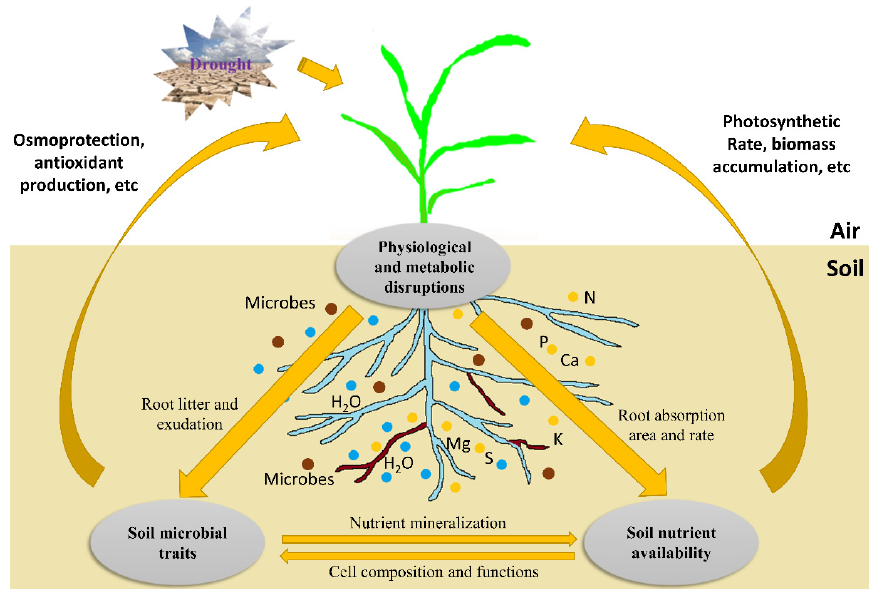
Figure 1. A framework showing drought effects on root physiological and metabolic processes and their interactions with nutrients and microbiomes in soil. Severe drought causes physiological and metabolic disruptions (see below for details). On the one hand, these disruptions influence nutrient uptake and metabolisms in plants, and vice versa. This feedback, in turn, affects biomass accumu- lation and grain yield. On the other hand, the inhibition of root litter and exudation production alters soil microbial traits (e.g., abundance, composition, and activity). These soil microorganisms may interact with roots in the rhizosphere, promoting plant growth via mycorrhizae colonization, osmoprotection, antioxidant production, etc. Under drought stress, soil microbes also affect nutrient availability through mineralization, and nutrients influence microbial growth via participation in their cell composition and functioning. Blue circles represent water resources in soil; yellow circles represent nutrient resources in soil; brown circles represent microorganisms in